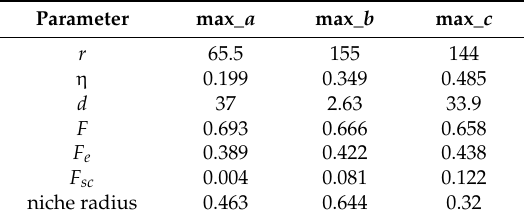
Table 3. Maxima found by means of PSALHE-EA considering a 1 µ m-thin-film solar cell. Parameter max_